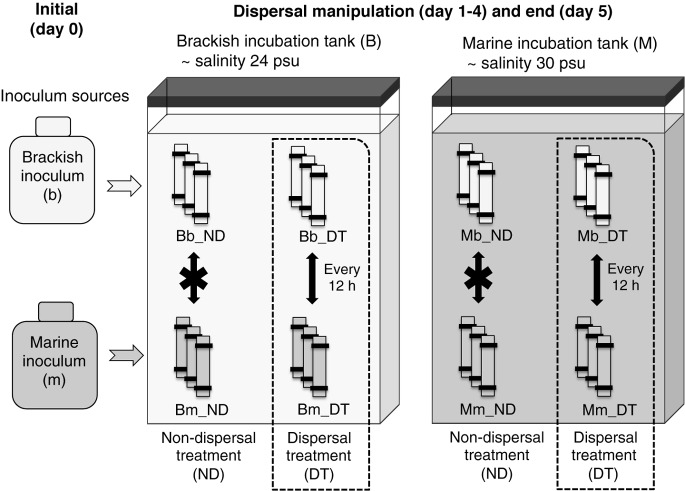
Experimental setup. Triplicate microcosms consisting of dialysis bags containing either a brackish or marine inoculum were reciprocally incubated in brackish and marine environments. B and M represent the brackish and marine incubation environments used in the incubations, respectively, and b and m represent the source (origin) of the initial brackish and marine inocula, respectively. ND indicates the treatments without dispersal, and DT indicates the treatments with dispersal. Combinations of these letters describe the particular incubation environment for the microcosms, the inoculum source, and the presence or absence of dispersal. For example, Bm_DT indicates microcosms in which the marine inoculum (m) was incubated in the brackish environment (B) and subjected to dispersal (DT).